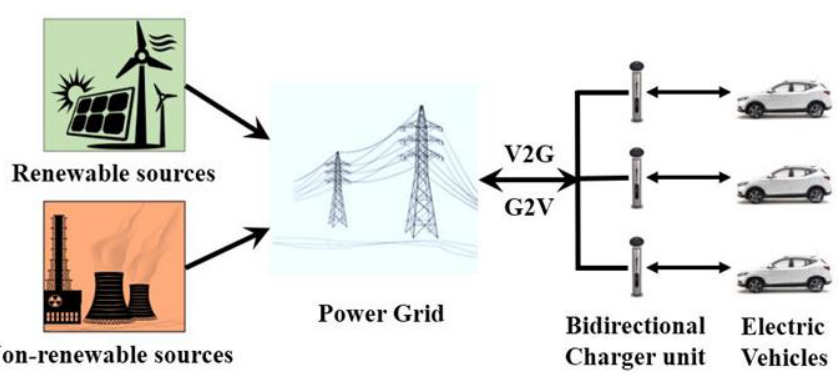
Figure 15. Vehicle-to-grid